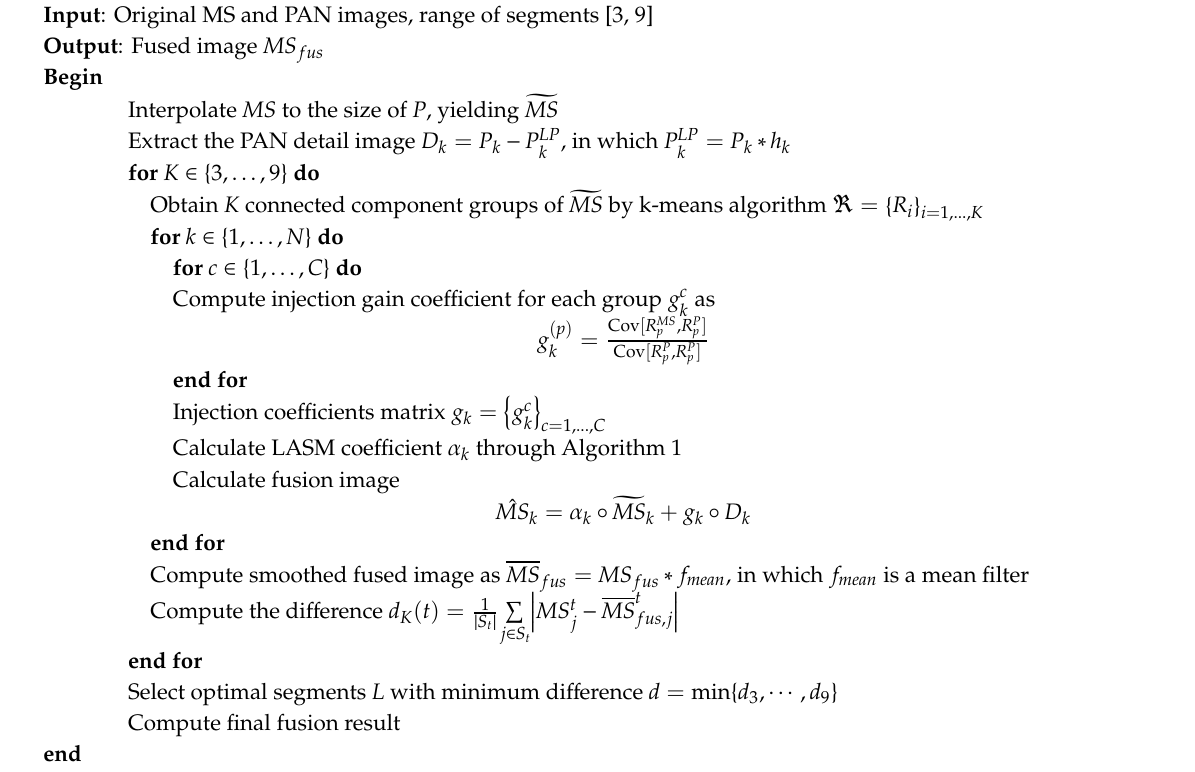
Algorithm 2 Pansharpening algorithm based on cooperation with segmentation